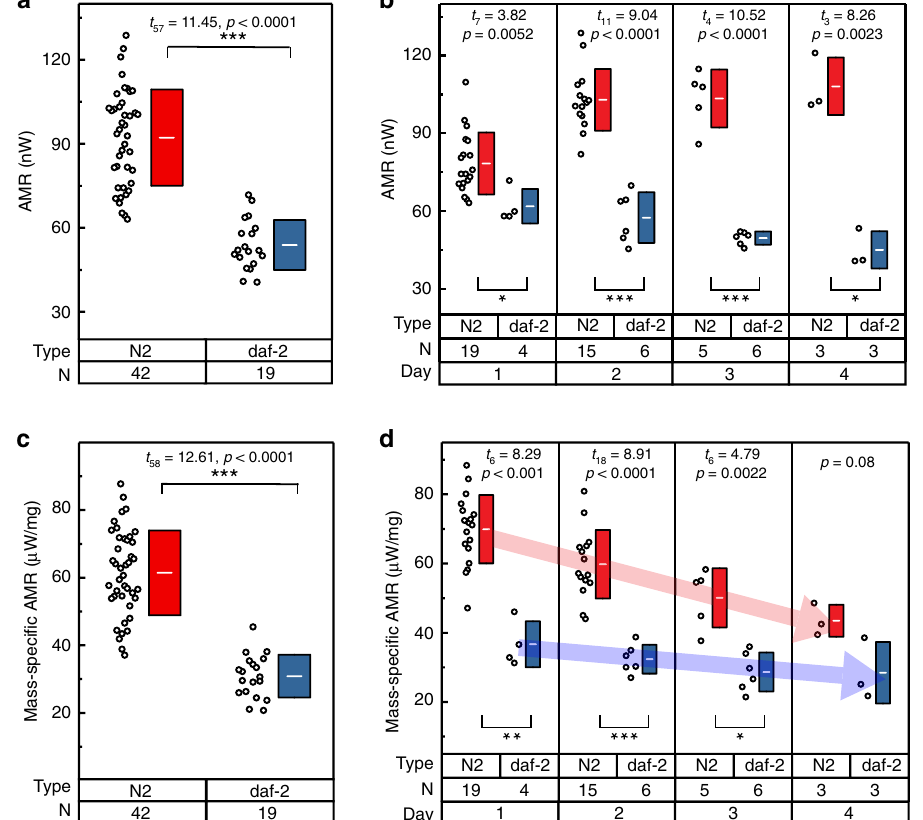
Fig. 5 Age-dependent metabolic heat output measurements on N2 wild-type and daf-2 mutant. a AMR from 42 worms of wild-type and 19 worms of daf- 2 from Day 1 – 4. The white line in the center of the box represents the mean value of the corresponding set, whereas the height of the box represents the standard deviation (±SD). N indicates the corresponding number of samples. b AMR of several worms (black circles) of wild-type (red) and daf-2 (blue) from Adult Day 1 – 4. c Mass-speci fi c AMR of the sample set in Fig. 5a. d Mass-speci fi c AMR is plotted for the same sample set in Fig. 5b. Statistical analysis was performed using two-tailed t test. Statistical signi fi cance was determined for p < 0.05; * p < 0.01, ** p < 0.001, *** p <